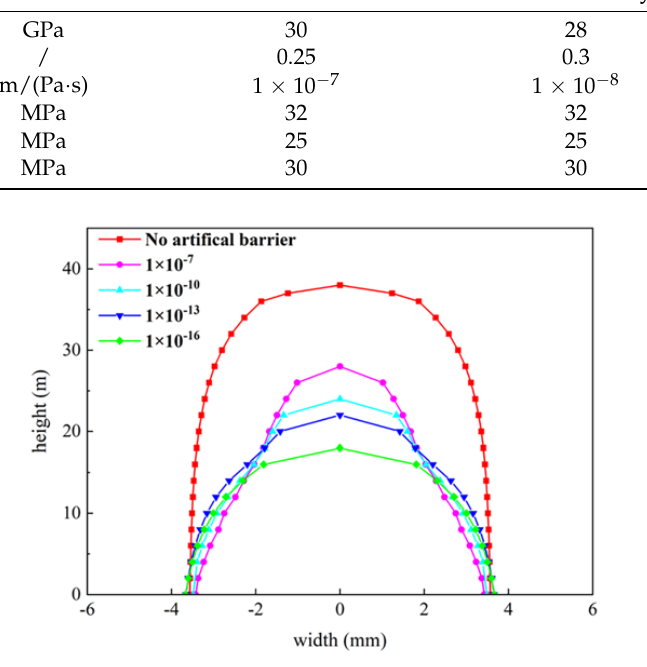
Figure 12. Fracture morphology at different leak-off coefficient of artificial barrier.